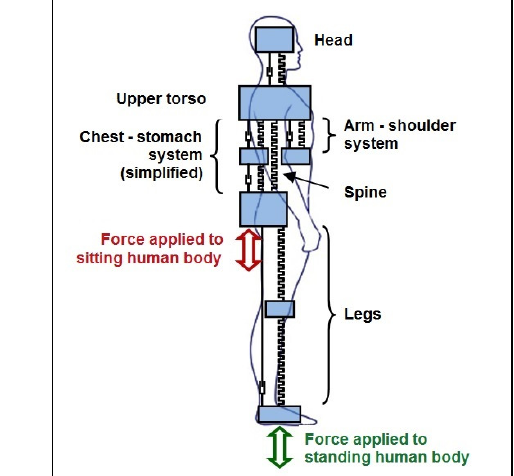
Figure 10 – Simplified mechanical system representing the human